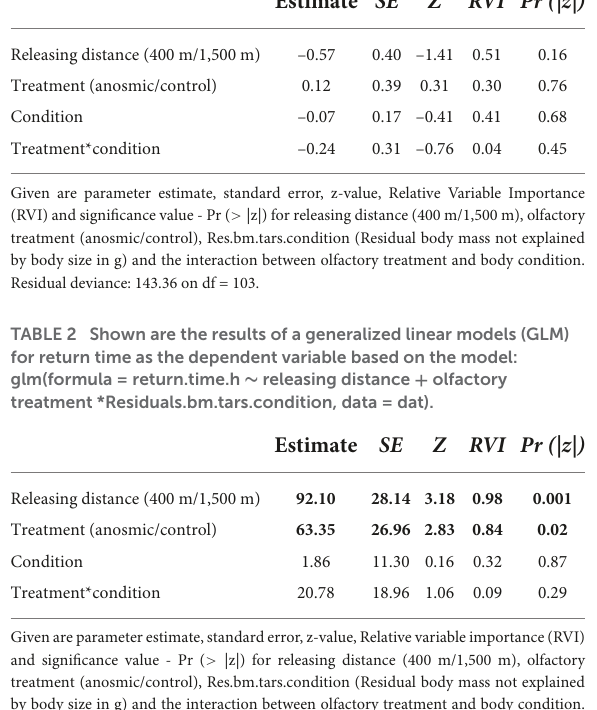
TABLE 1 Shown are the results of a generalized linear models (GLM) for return rate as the dependent variable based on the model: glm(formula = returned ∼ releasing distance + olfactory treatment * Res.bm.tars.condition, family = binomial).